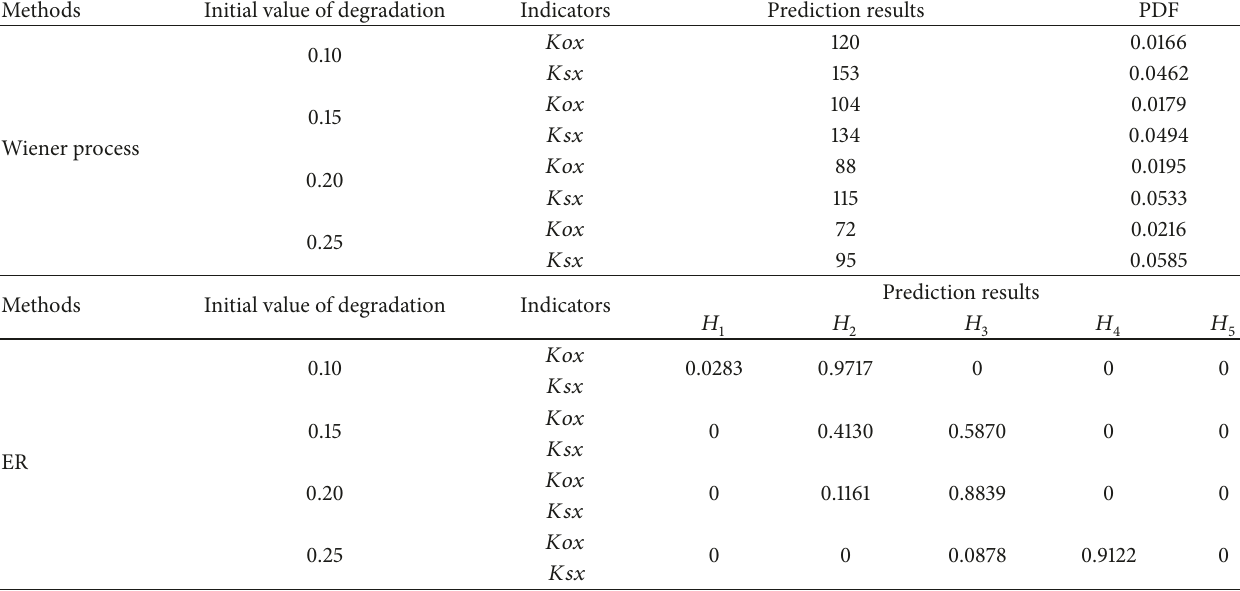
Table 8: The final results by ER.